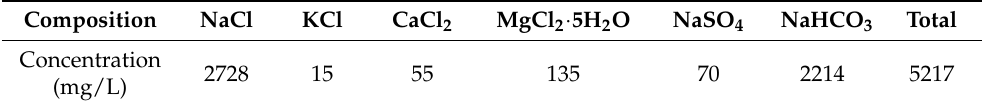
Table 2. Composition of the synthetic brine